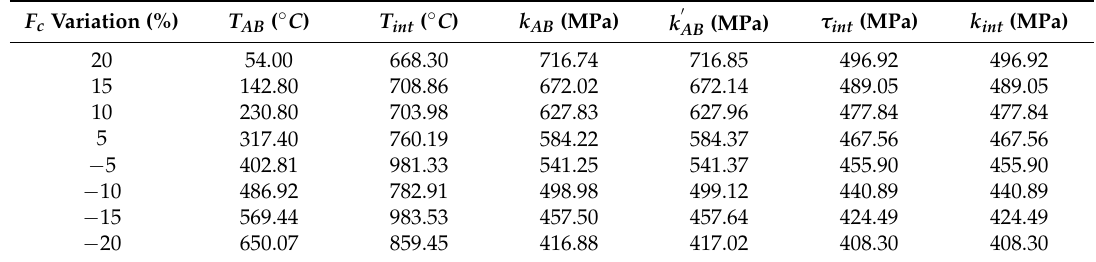
Table A1. Variables in sensitivity analysis of cutting force under test 1 cutting